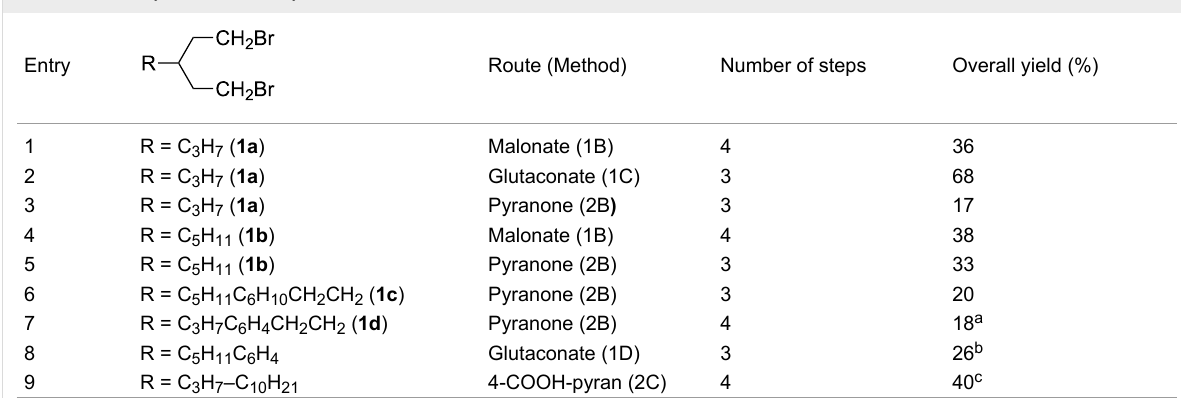
Table 2: Summary of dibromide 1